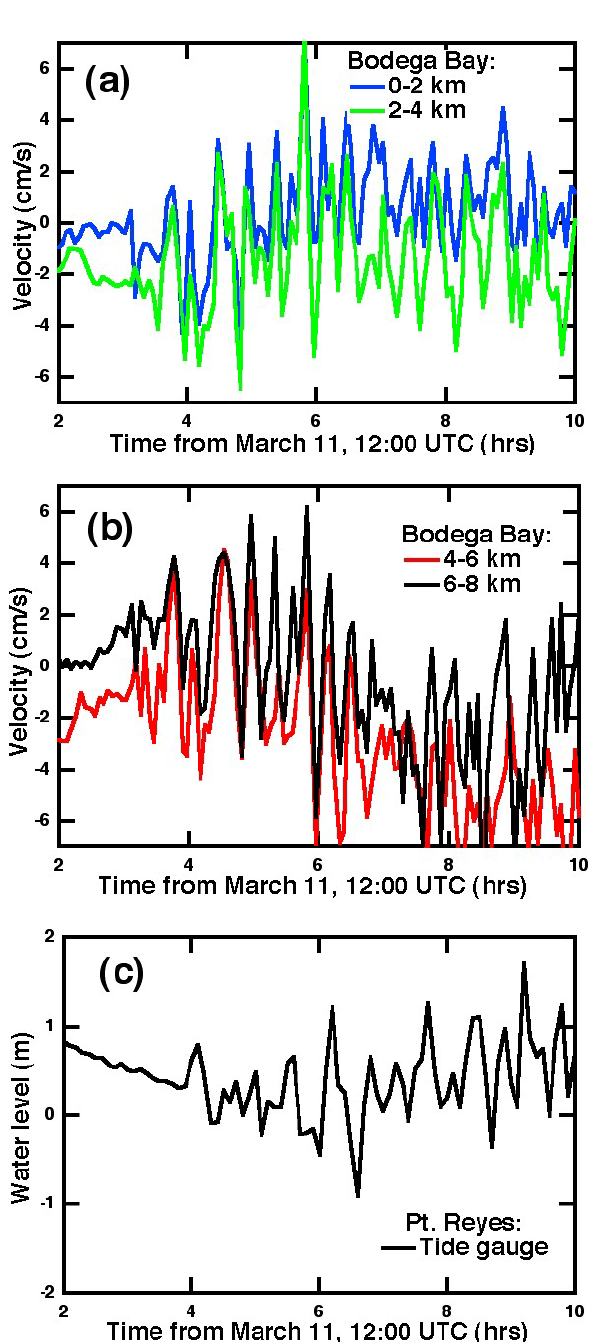
Figure 6. Time series of velocity components from the radar at Bodega Bay and simultaneous water level observations from the Point Reyes tide gauge. Radial velocities were resolved perpendicular to the shore, and averaged over bands 2-km wide parallel to the